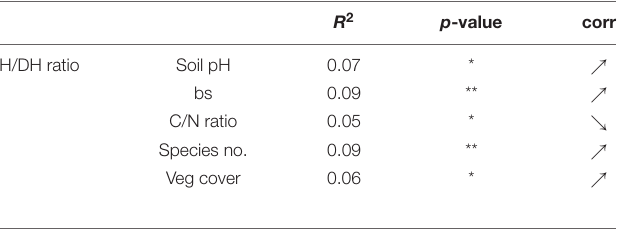
TABLE 3 | Relationships between the H/DH ratio of the SL content in A. montana flower heads from Apuseni Mountains, Romania and environmental parameters: soil pH, base saturation (bs), C/N ratio, the species number per plot (species no.) and the vegetation cover in percentage (veg cover). R 2 p -value